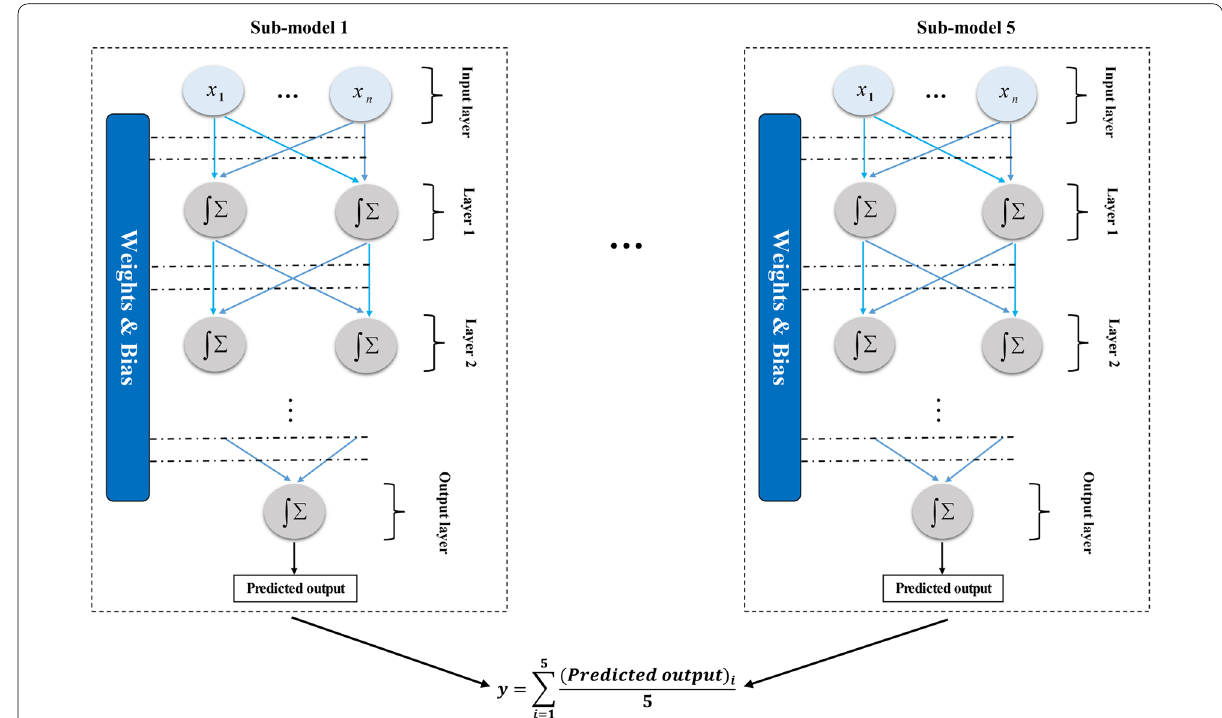
Fig. 5 Model averaging ensemble